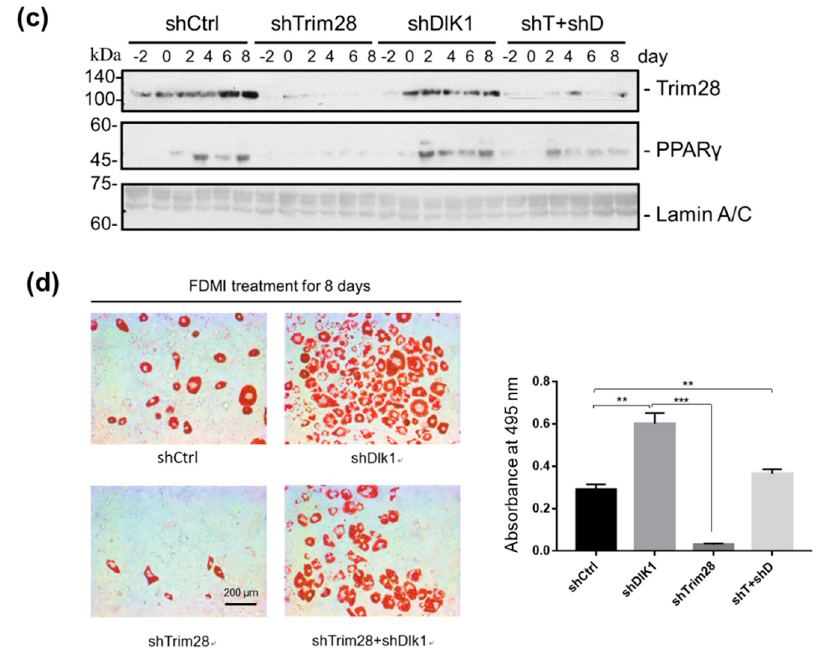
Figure 4. Knockdown of Dlk1 in Trim28 KD 3T3-L1 rescues cell differentiation. ( a ) Real-time PCR analysis of Dlk1 and Trim28 mRNA expression in 3T3-L1 cells transduced with lentiviral shRNA vectors for a standard control, Dlk1, Trim28, and Trim28+ Dlk1. **** p < 0.0001 ( b ) Real-time PCR analysis of Pparg expression in 3T3-L1 cells as described in ( a ) after differentiation for zero days and two days. Quantitative PCR data were estimated by two-way ANOVA, **** p < 0.0001, ** p < 0.01, * p < 0.05. ( c ) Western blot analysis of nuclear extracts from indicated 3T3-L1 cells induced differentiation for zero to eight days. The Trim28 and PPAR γ protein expression was detected. The expression of the 63-kDa Lamin C and 74-kDa Lamin A isoforms was used as a loading control. ( d ) Oil red O staining of the fat droplets on the indicated knockdown 3T3-L1 cells induced differentiation for eight days. Oil red O was dissolved in isopropanol consequently, and the content of dissolution was measured by spectrophotometer at OD 495 nm. P value was estimated by one-way ANOVA, *** p < 0.001, ** p < 0.01.